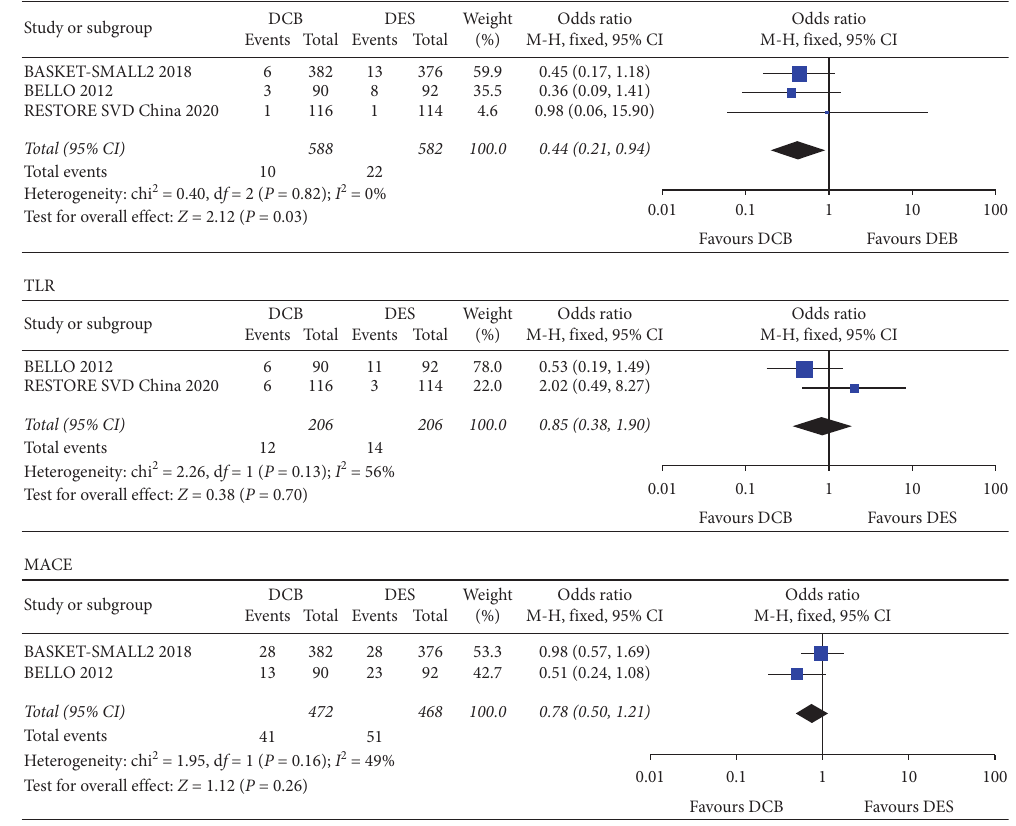
Figure 5: Forest plots comparing DCB with DES in MI, TLR, and MACE (excluded PICCOLETO trial). MACE, major adverse cardiac events; MI, myocardial infarction; TLR, target lesion